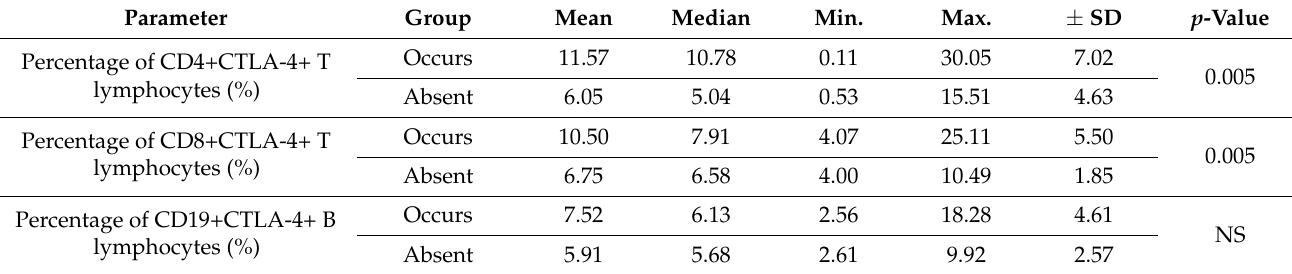
Table 2. Percentage of CD4+ T lymphocytes, CD8+ T lymphocytes and CD19+ B lymphocytes expressing the CTLA-4 antigen among peripheral blood lymphocytes in women with endometriosis depending on the coexisting adhesion